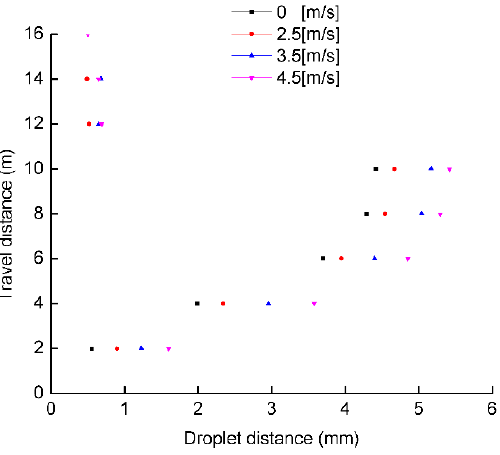
Figure 6. Effect of wind speed on droplet size distribution compared with zero wind conditions at constant pressure (150 kPa).